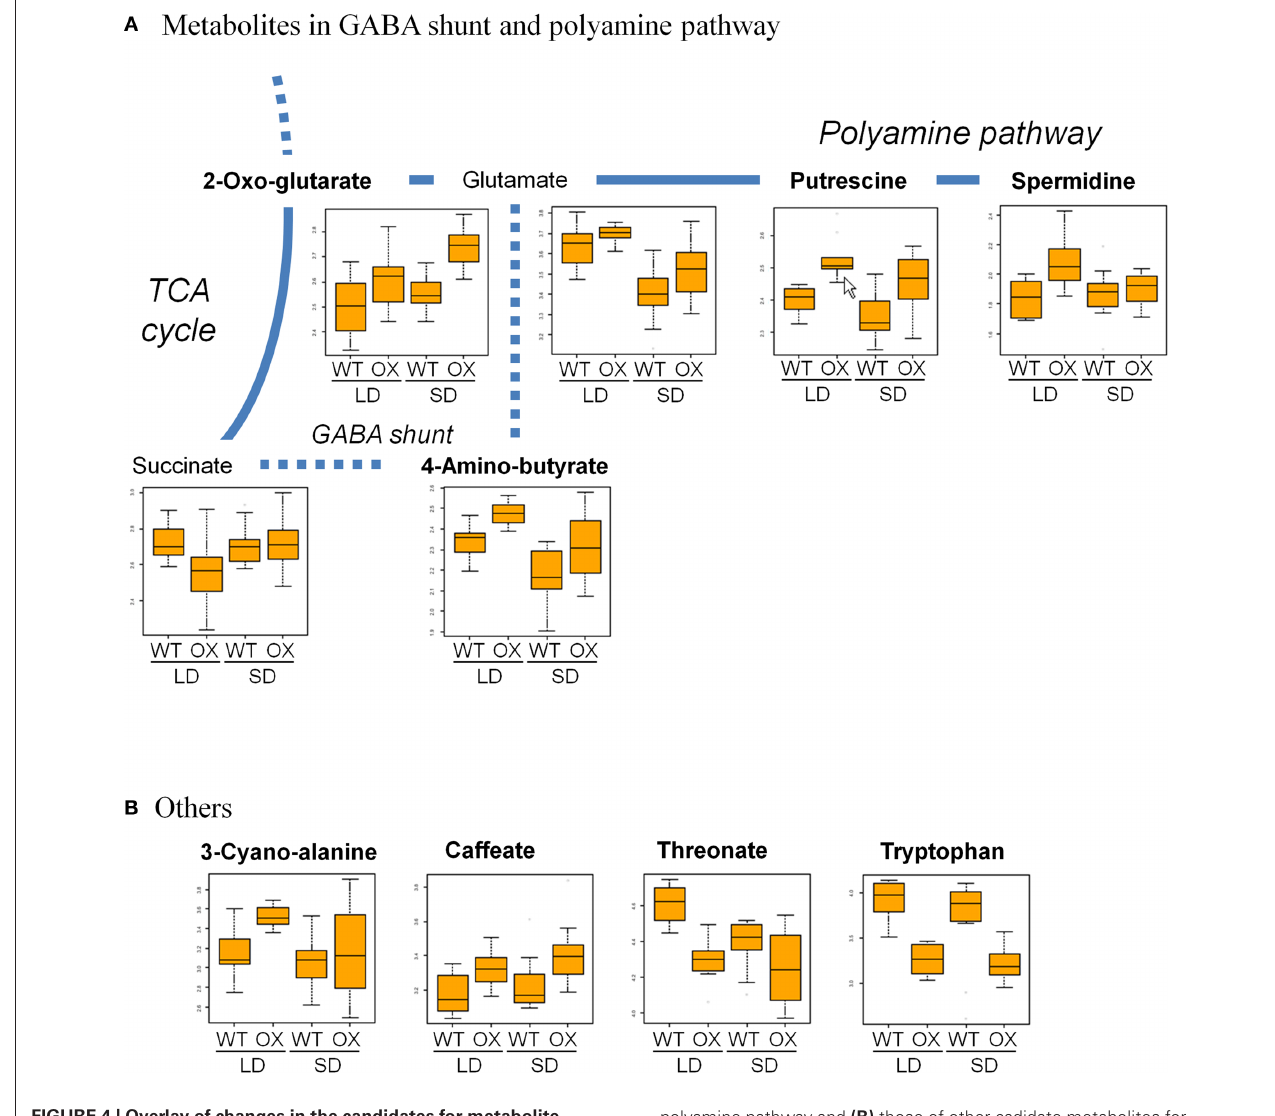
polyamine pathway and (B) those of other cadidate metabolites for metabolite signature. In each box plot, x -axis represents metabolites detected in WT and PHYAOX (OX) in LD and SD, while y -axis shows the normalized response of metabolite levels after log 10